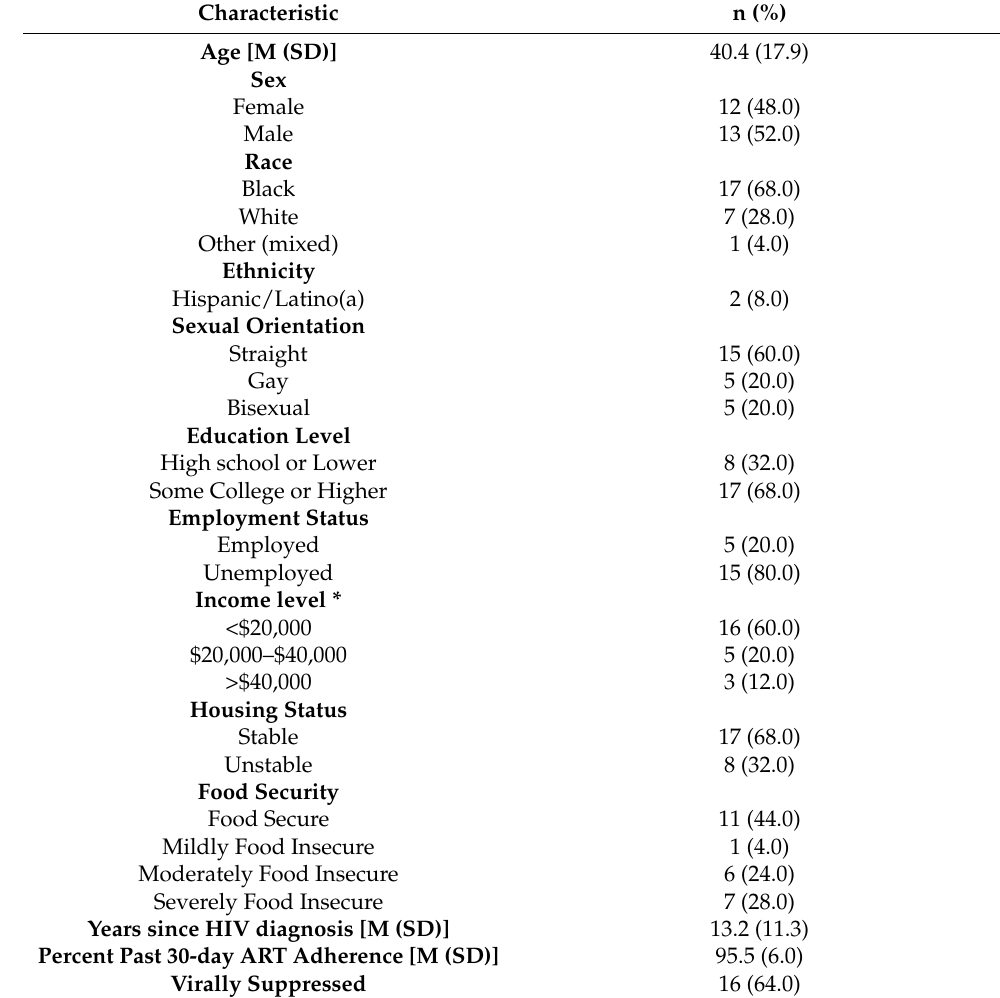
Table 1. Participant Characteristics (N = 25).